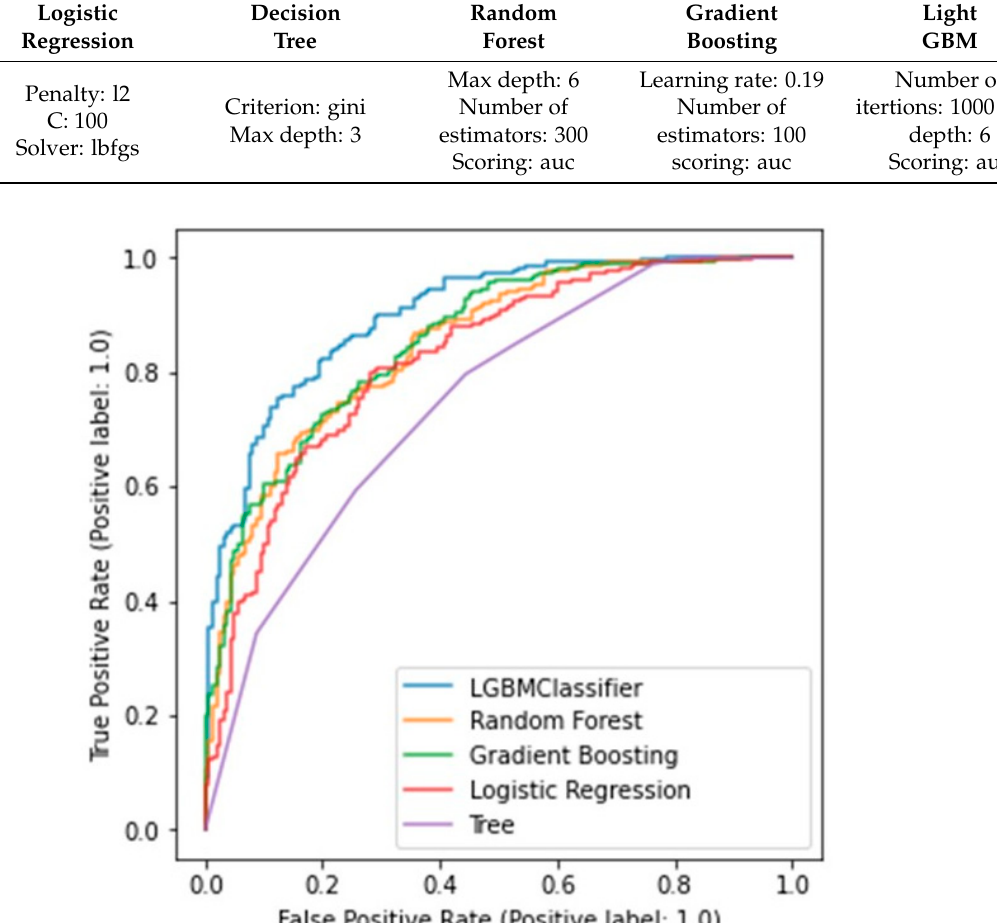
Figure 2. ROC curve of each trained model (LGBMClassifier: lightGBM; Tree: decision tree).